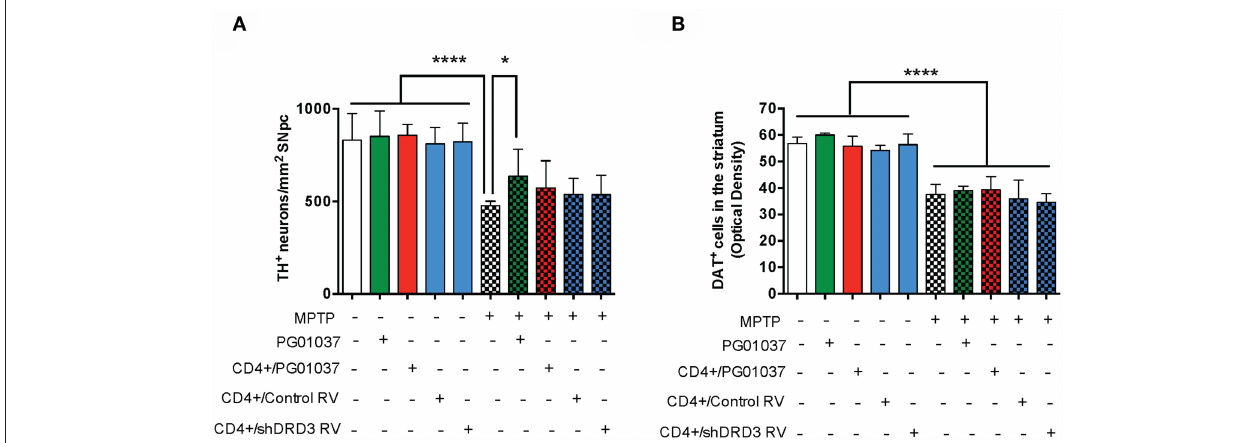
FIGURE 6 | Comparison of the therapeutic potential of the systemic DRD3-antagonistm or the intravenous transference of CD4 + T-cells transduced with shRNA for DRD3 or treated with a DRD3 antagonist on neurodegeneration of MPTPp-treated mice. CD4 + T-cells (4 × 10 5 cells per mouse) were treated with 20nM PG01037 (red) or transduced with retroviral particles (MOI = 1) codifying for RV-Control or RV-shDRD3 (blue) and then i.v. injected in experimental animals 1 day after the first MPTPp injection. Mice treated with systemic DRD3-antagonism (green) received 9 i.p. injections of PG01037 (30 mg/kg) administered 1 day after MPTPp injections starting after the second MPTPp administration (see scheme in Figure 5A ). Neurodegeneration was analysed 1 week after the last MPTPp injection. Dopaminergic neurons were quantified by immunohistochemical analysis of tyrosine hydroxylase (TH) in the substantia nigra pars compacta (SNpc) (A) and dopamine transporter (DAT) in the striatum (B) . Data represent the mean with the SEM. One-way ANOVA followed by Tukey’s multiple comparison post-hoc test were used to determine statistical differences: * p < 0.05; **** p < 0.0001 n = 5–7 (A) or n = 5–11 (B) mice per